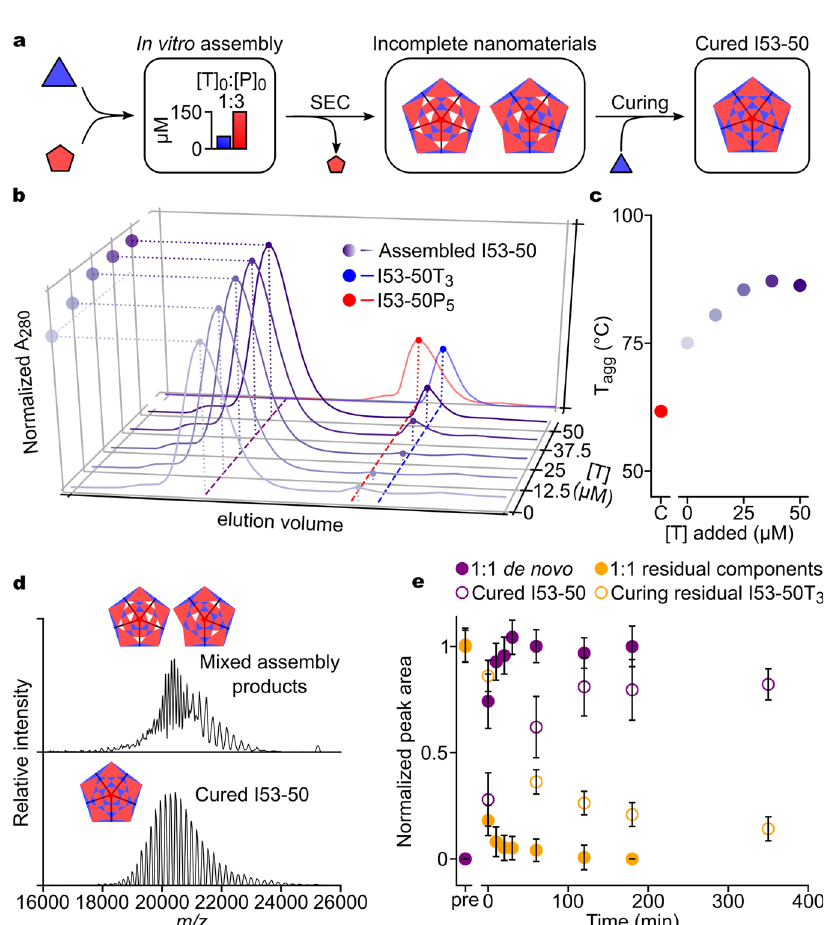
Fig. 5 Curing of incomplete I53-50 assemblies by post-assembly addition of trimer. a Schematic for aberrant assembly subsequently cured by addition of free trimer. b SEC analysis of curing reactions, where shades of purple indicates the amount of free trimer added. c T agg of SEC-puri fi ed cured nanomaterials. The concentration of the uncured aberrant assembly (0 μ M added T) was adjusted such that its absorption at 280 nm signal was equivalent to 70 μ M nanomaterial assembled at [T] 0 = [P] 0 . d Native MS of incomplete assembly reaction after SEC (top) displaying at least two charge state series. After trimer addition, the spectrum shows a distinct, single charge state series corresponding to the complete 120-subunit nanomaterial (bottom). e SEC analysis of de novo assembly reactions at [T] 0 = [P] 0 = 12.5 μ M ( fi lled circles) and curing reactions comprising 12.5 μ M additional T (open circles) incubated for varying amounts of time. Average peak area is normalized to reaction endpoints. Error bars are the standard deviation of three replicates. Source data are provided as a Source Data fi